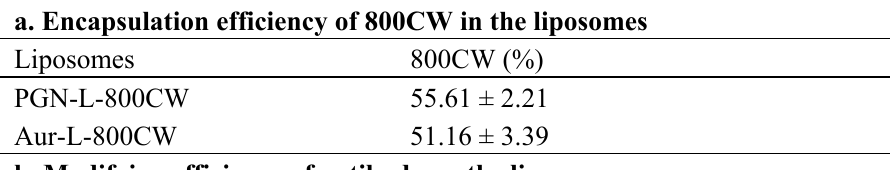
Table 1. Characteristics of liposomal